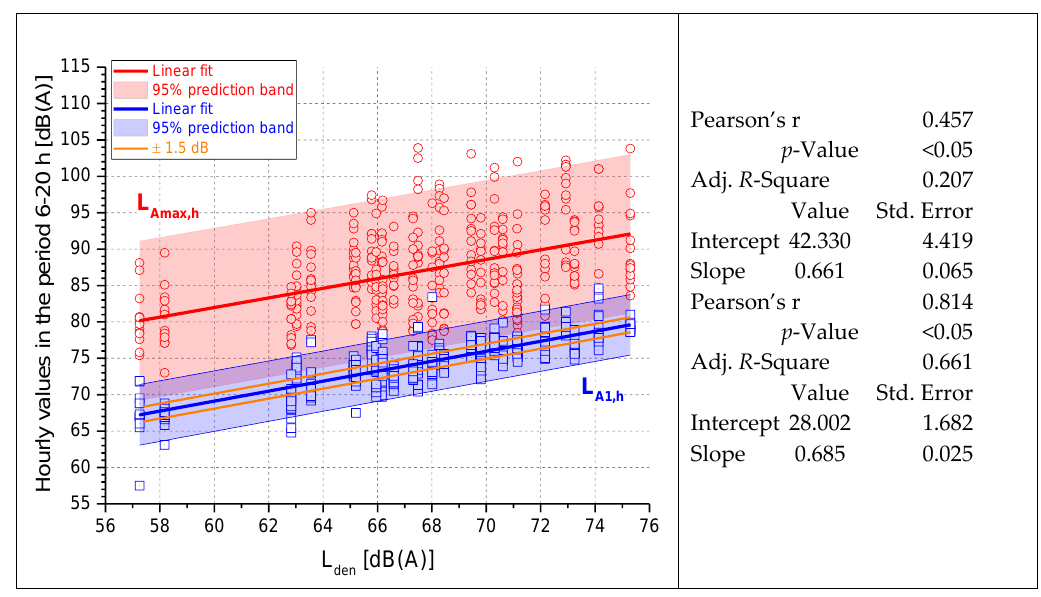
Figure 6. Linear regressions between hourly values of both L Amax and L A1 versus L den for all the streets. The correlation between L A1 and L den is higher (R 2 = 0.661) than that observed for L Amax (R 2 = 0.207) due to a greater dispersion of data for the latter. Indeed, L Amax measured in a time interval of 1 h may be influenced by unusual events, such as very noisy vehicles or sirens. However, these events are often present in traffic noise and it would be inappropriate to exclude them from the analysis. The difference between the regression slopes of L Amax and L A1 is statistically not significant at the 95% confidence level ( p -value = 0.725). Dealing with the accuracy of predicted values, the standard deviation of the error is ±5.5 dB for L Amax and and ±2.1 dB for L A1 , whereas the median value of the error is 0.3 and 0.2 dB, respectively. The percentage of errors (predicted – observed values) within the range ±1.5 dB is 21.4% for L Amax and 54.3% for L A1 . The range of ±1.5 dB has been chosen because its width (3 dB) corresponds to a doubling of sound energy. Similar results have been obtained for the linear regressions between the hourly values in the day-time 6 – 22 h of both L Amax and L A1 versus the corresponding values of L Aeq, 6 – 22 h (data matrix formed of three columns and 28 roads × 16 h = 448 rows), as shown in Figure 7. The correlation between hourly L A1 values and L Aeq, 6 – 22 h is much higher (R 2 = 0.688) than that observed for L Amax (R 2 = 0.223), while the difference between the regression slopes of L Amax and L A1 is statistically not significant at the 95% confidence level ( p -value = 0.523). Dealing with the accuracy of predicted values, the standard deviation of the error is ±5.3 dB for L Amax and ±2.0 dB for L A1 , whereas the median value of the error is 0.3 and 0.2 dB respectively. The percentage of errors (predicted – observed values) within the range ±1.5 dB is 19.6% for L Amax and 60.5% for L A1 . Figure 8 shows the results of the linear regressions between the school hours 8 – 17 h of both L Amax and L A1 versus the corresponding values of L Aeq, 6 – 22 h (data matrix formed of three columns and 28 roads × 9 h = 252 rows). Again, the correlation between hourly L A1 values and L Aeq, 6 – 22 h is much higher (R 2 = 0.737) than that observed for L Amax (R 2 = 0.261), while the difference between the regression slopes of L Amax and L A1 is statistically not significant at the 95% confidence level ( p -value = 0.607). The